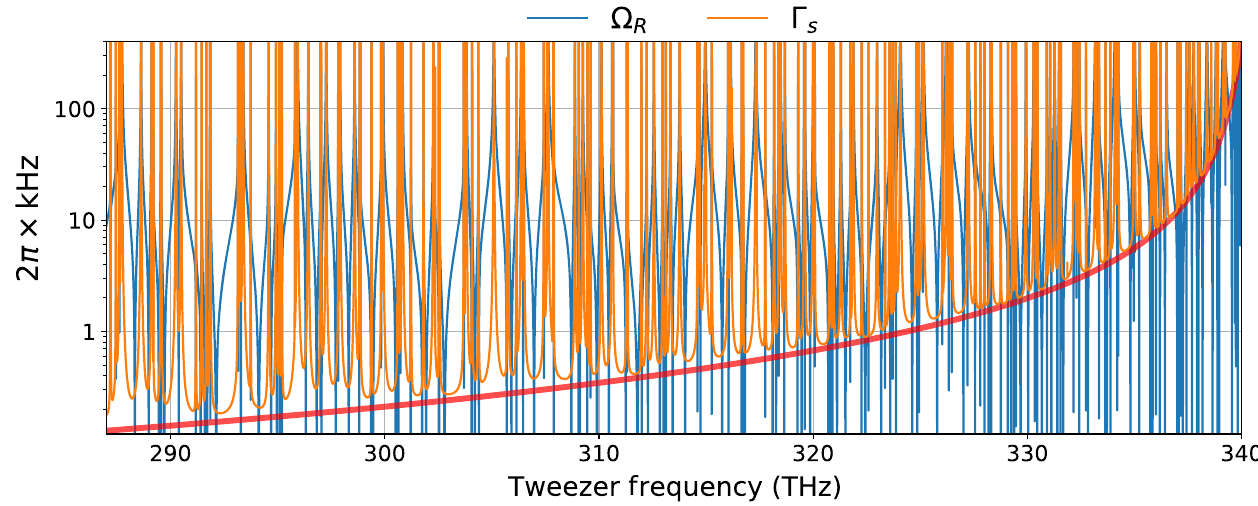
FIG. 7. Full calculation of the Raman Rabi frequency and scattering rate as a function of the single-photon frequency including all vibrational states of c 3 Σ þ ð Ω ¼ 1 Þ and the atomic continuum. The second frequency in the Raman transition is offset by about 770 MHz and resonant with the two-photon transition. The assumed excited-state linewidth for all molecular lines is 50 MHz. The red line shows the contribution that comes only from the near-threshold states.